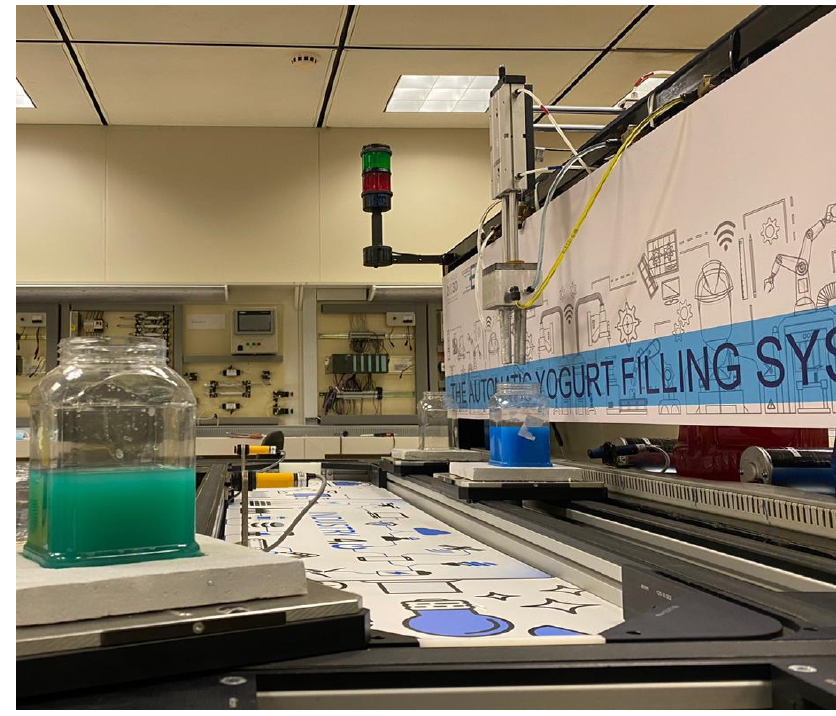
Figure 2. Modified setting of the yogurt filling system (Case-II).